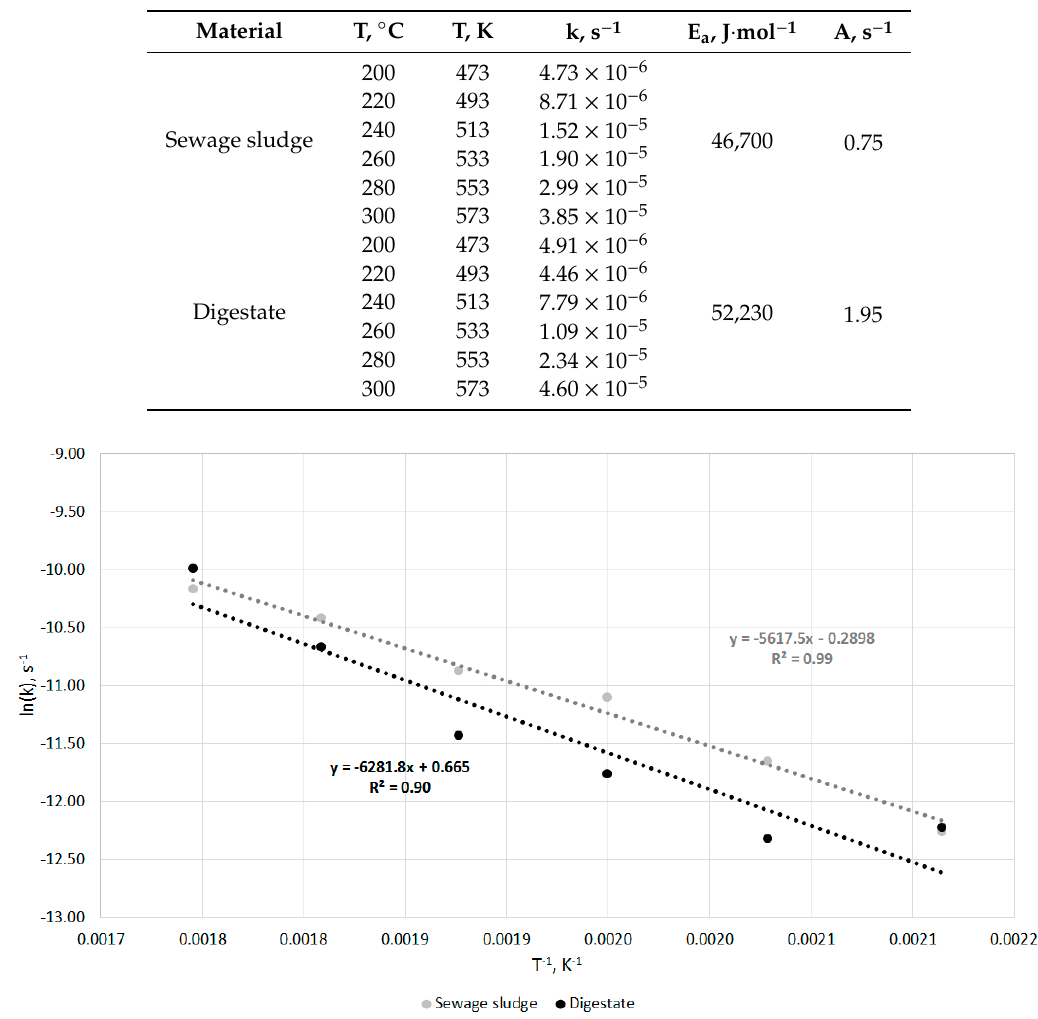
Figure 12. TGA of digestate at torrefaction temperatures. Table 1. Summary of kinetic parameters of the torrefaction process.